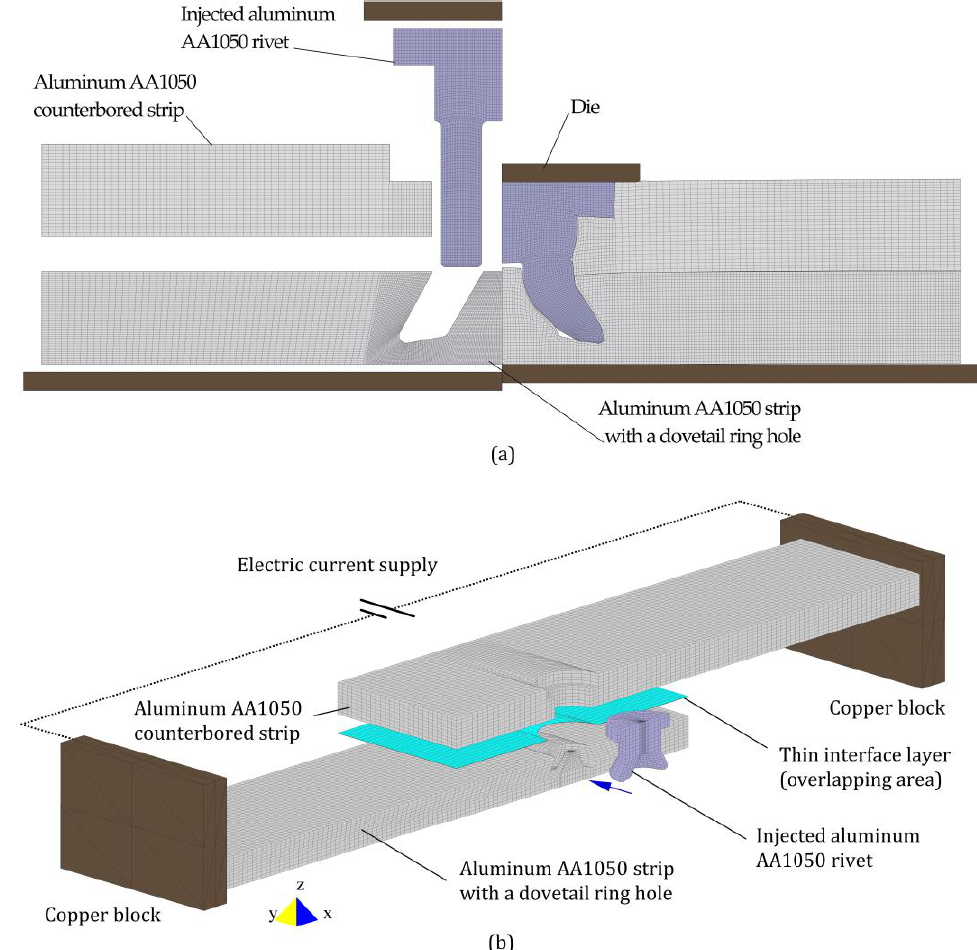
Figure 5. Finite element modelling of the injection lap riveted unit cells showing ( a ) a rotational symmetric model utilized in the simulation of mechanical joining at the beginning and at the end of the process and ( b ) a three-dimensional model utilized in the thermo-electric simulation.